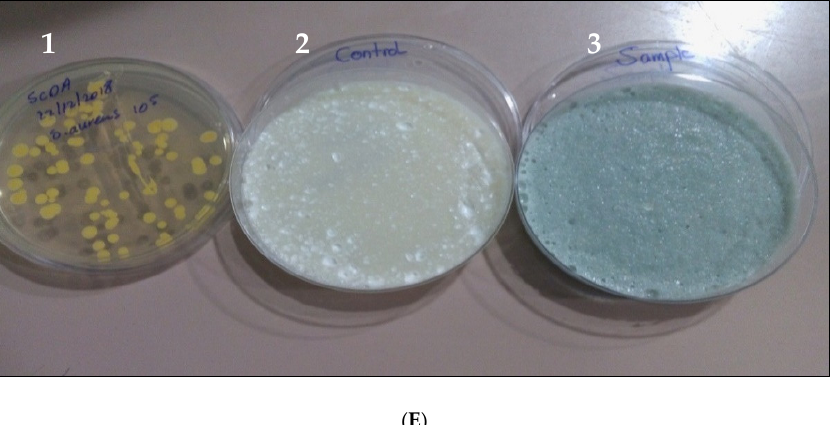
Figure 3. ( A ) (1): Cultured pathogen, (2): FucidinTM (control), and (3): F2 (sample) effect on E.coli isolate. ( B ) (1): Cultured pathogen, (2): FucidinTM (control), and (3): F2 (sample) effect on C. albicans isolate. ( C ) (1): Cultured pathogen, (2): FucidinTM (control), and (3): F2 (sample) effect on A. niger isolate. ( D ) (1): Cultured pathogen, (2): FucidinTM (control), and (3): F2 (sample) effect on P. aeruginosa isolate. ( E ) (1): Cultured pathogen, (2): Fucidin TM (control) and (3): F2 (sample) effect on S. aureus isolate.